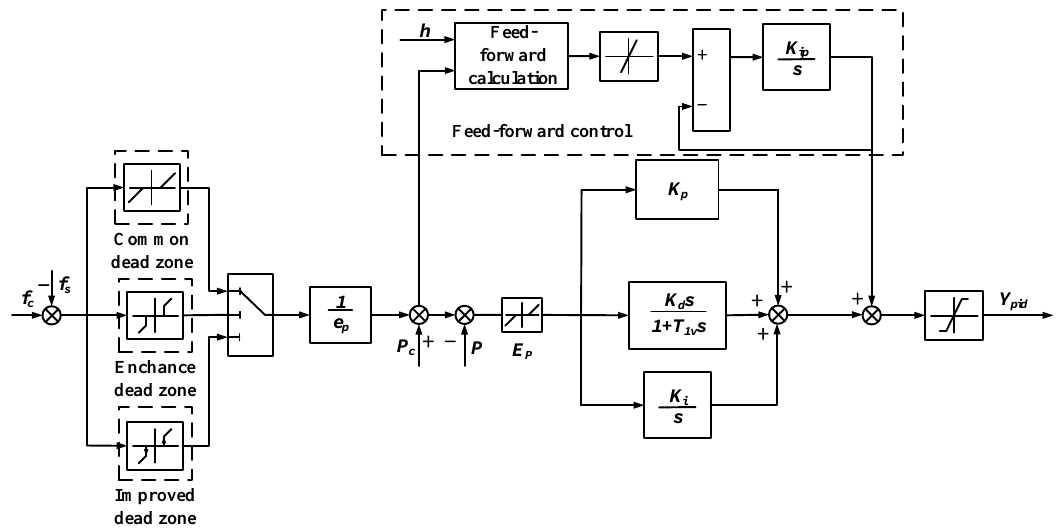
Figure 6. The regulator model with common, enhanced, and improved dead zones and feed-forward control; e p is the regulation ratio; P c is the given power; P is the real power; E p is the power dead zone; K ip is the integral gain for feed-forward control.